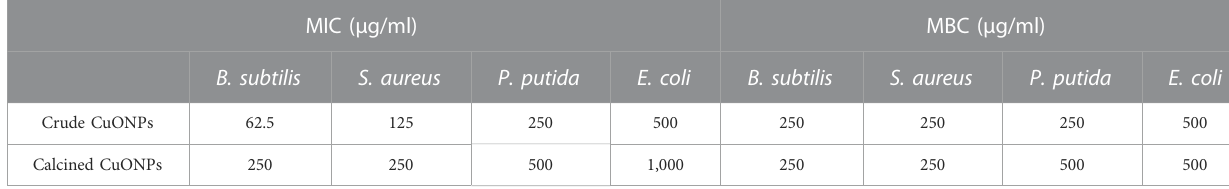
TABLE 2 The MIC and MBC of biogenic CuONPs against different Gram-positive and Gram-negative